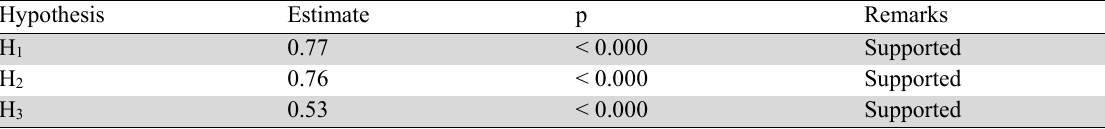
Standardized path